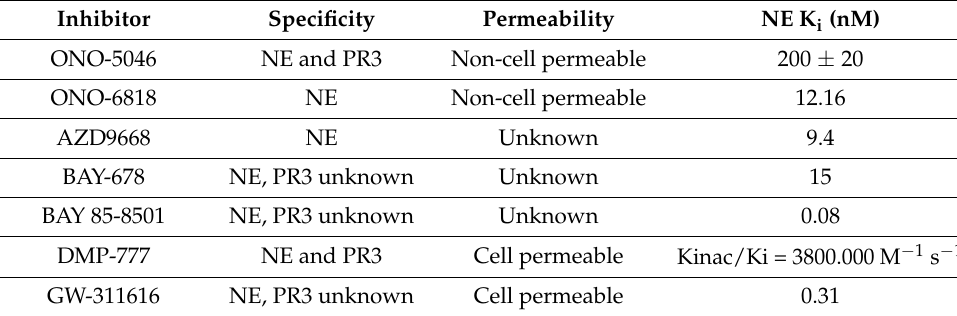
Table 1. NE and/or PR3 specific inhibitors and their properties.